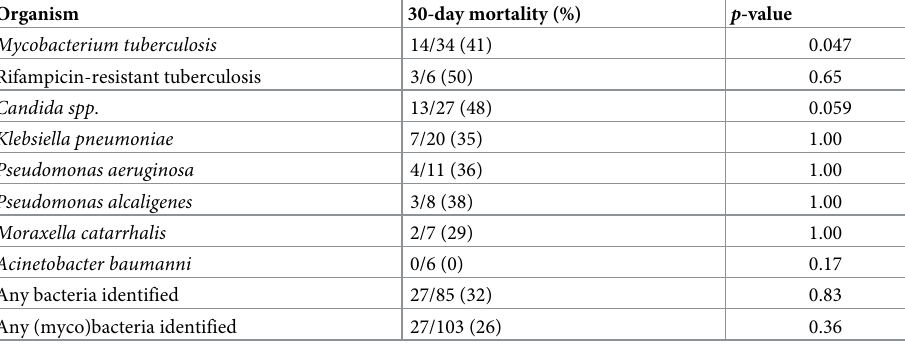
Table 3. 30-day mortality stratified by an isolated